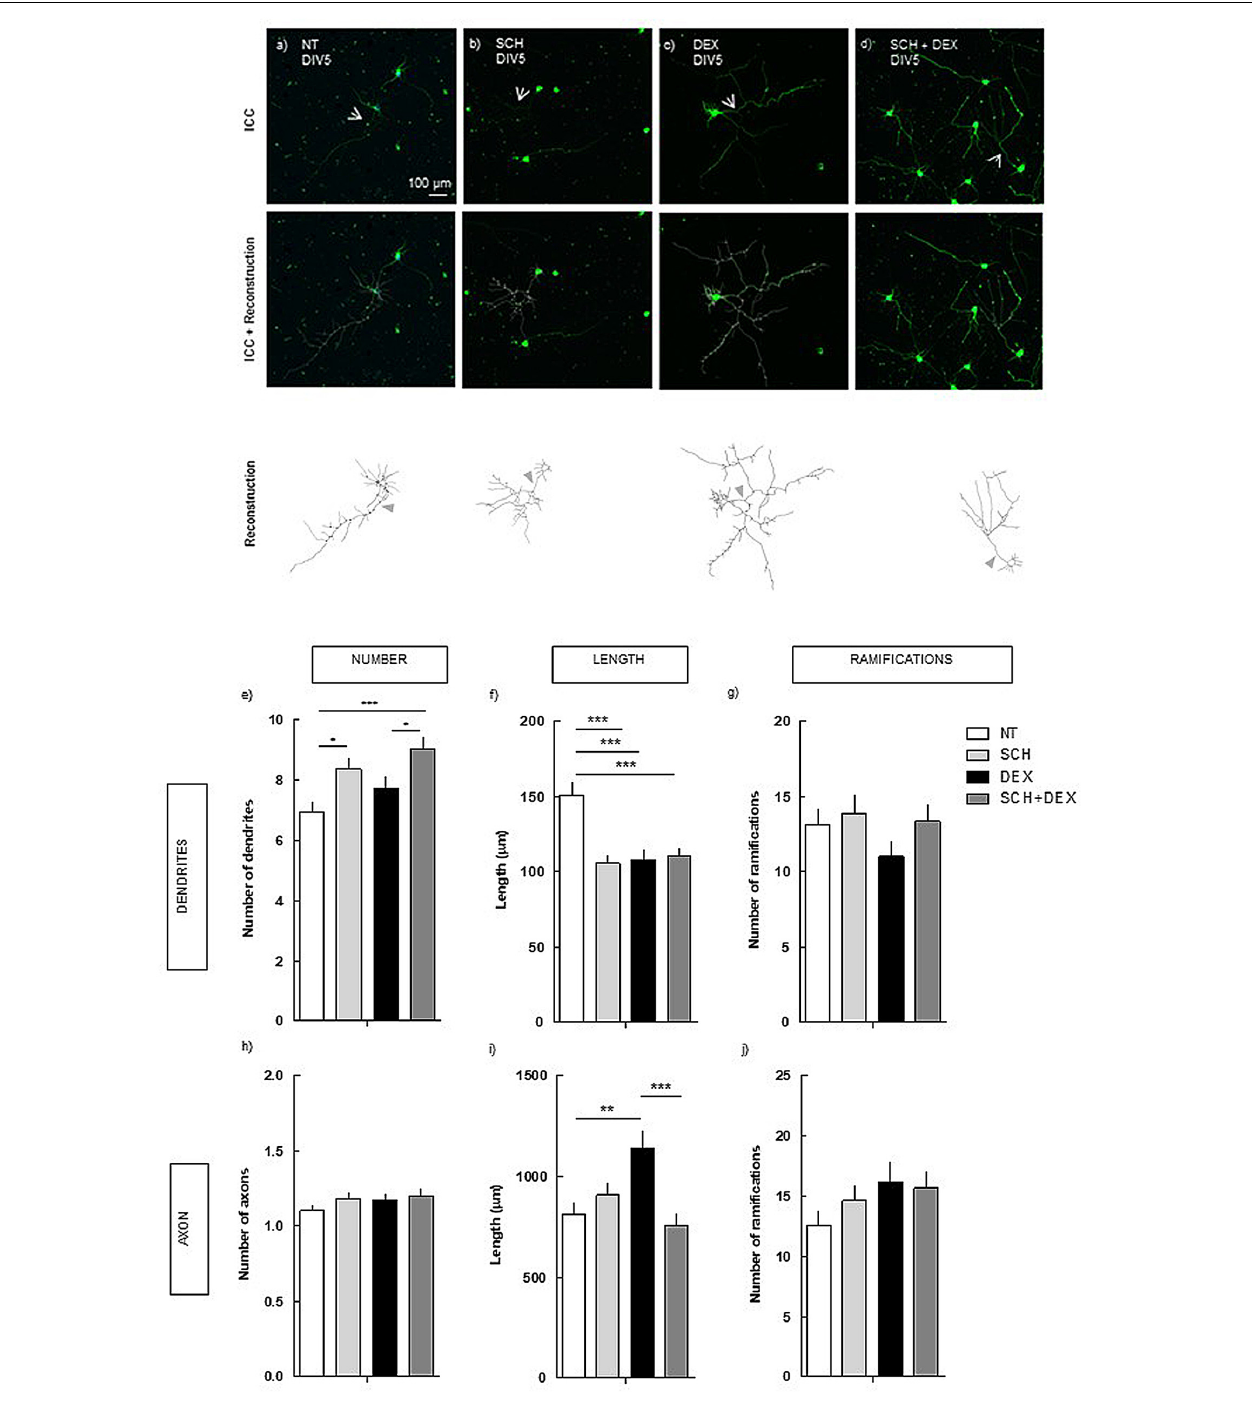
FIGURE 2 | Effect of the blockade of A 2A R per se and on DEX exposure (4 days treatment) in hippocampal neurons (DIV5). Hippocampal neurons from ED18 rats were cultured in vitro for 5 days (DIV5). Cultured neurons were treated with the A 2A R antagonist, SCH (50 nM), or with the A 2A R antagonist and/or DEX (250 nM; at 24 h in culture). SCH was added 15 min before DEX. Neuronal morphology was assessed by manual reconstruction in Neurolucida software (a–d) and morphometric data were acquired in Neurolucida Explorer, regarding the number (e) , length (f) , and number of ramifications (g) of dendrites and the number (h) , length (i) , and number of ramifications (j) of axons (identified with an arrow in the representative images). Results are expressed as mean ± SEM of 120 cells, from five independent experiments. Statistical significance was assessed by one-way ANOVA followed by Tukey’s Multiple Comparison Test: ∗ p < 0.05, ∗∗ p < 0.01, ∗∗∗ p < 0.001, as indicated by the horizontal lines above the columns. ICC, immunocytochemistry; NT, non-treated; SCH, SCH58261, A dexamethasone; SCH+DEX, SCH58261 + Dexamethasone.